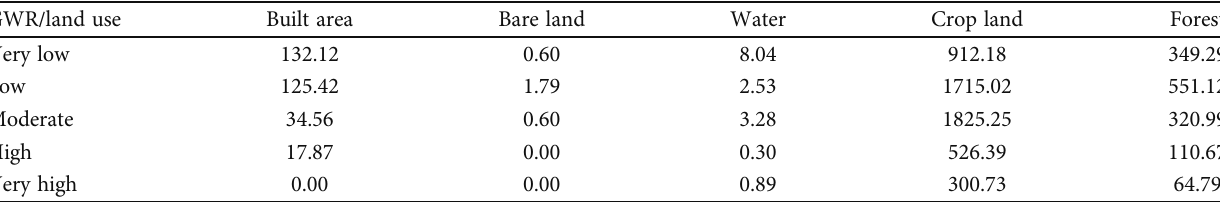
Table 15: Cross-tabulation between GWR and land